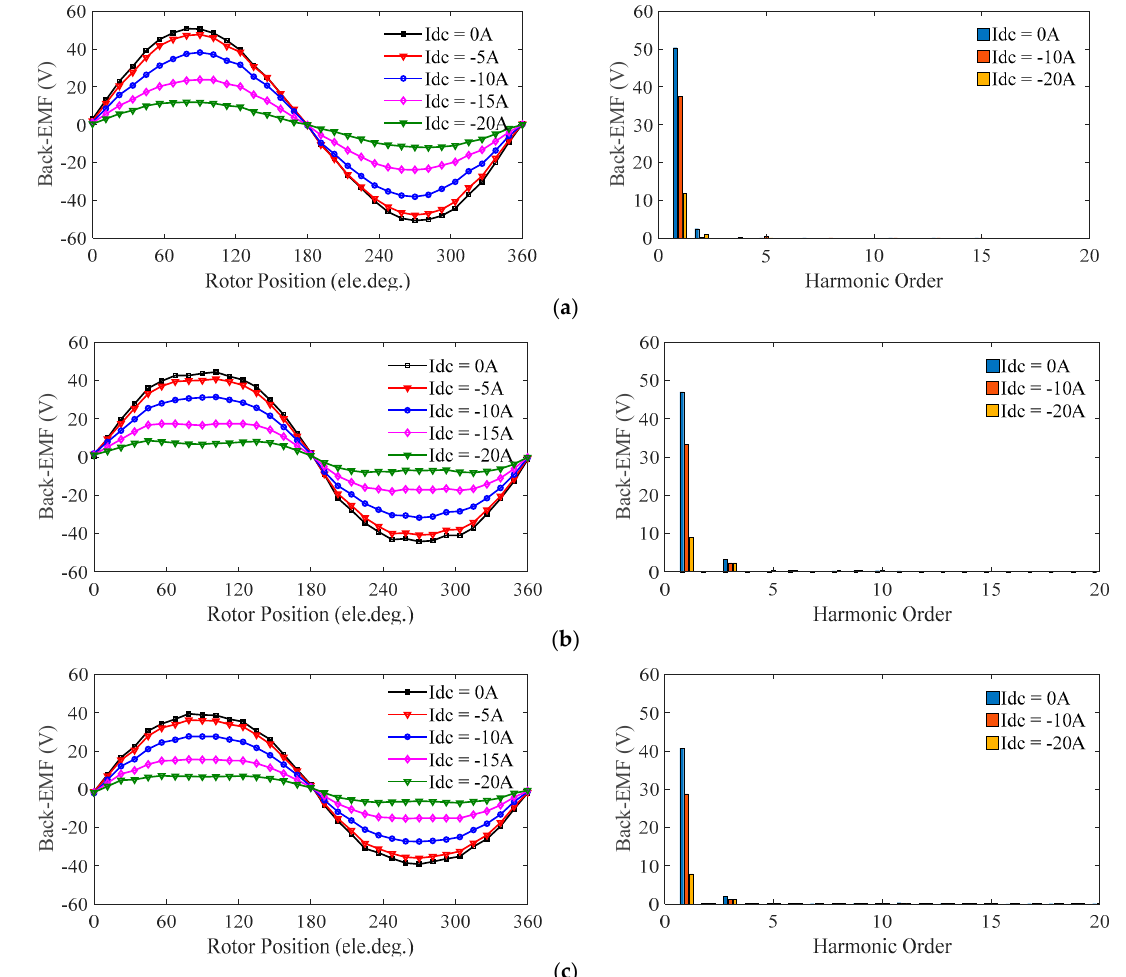
Figure 8. Back–EMF waveforms and harmonic spectra under variation of DC excitations with different PRs at rated speed. ( a ) PR of 8/1. ( b ) PR of 17/1. ( c ) PR of 35/1. Table 2. The THD of the proposed DR-HEAFPMVMs with different PRs.